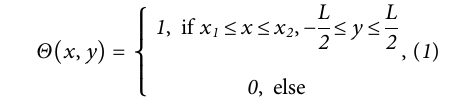
Figure 1B and Figure 1C represent the typical distributions of the transforming and correcting phases,